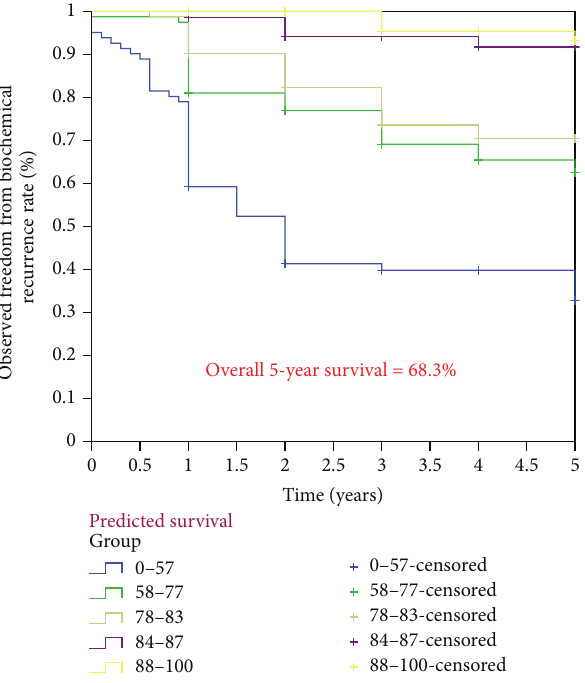
Figure 1: Observed freedom from biochemical recurrence rates according to the 1998 Kattan